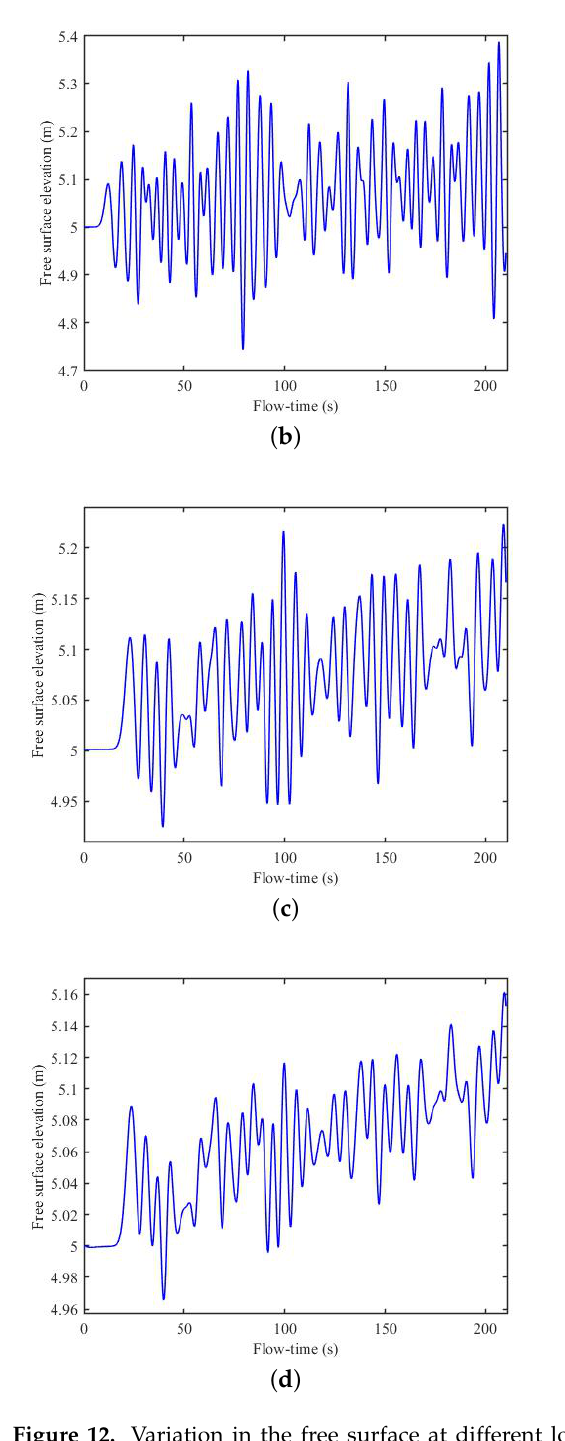
Figure 12. Variation in the free surface at different locations: ( a ) x = 0.5 m, ( b ) x = 72.025 s, ( c ) x = 143.5 m and ( d ) x = 146.4 m, with H s = 0.9 m and ω p = 1.25